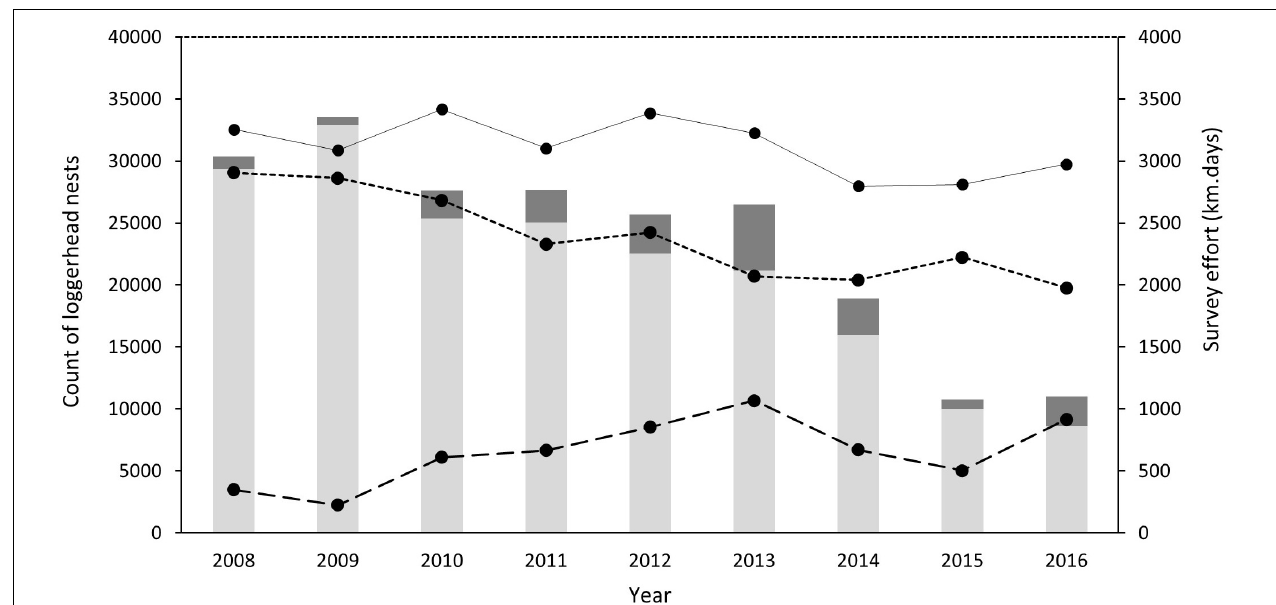
FIGURE 2 | Annual loggerhead nest counts and survey effort of index and non-index beaches on Masirah (2008–2016). Light gray bars represent total annual counts of nests on index beaches and dark gray total annual counts of nests on non-index beaches. Points associated with the continuous line represents the annual survey effort for all beaches, the short-dashed line represents survey effort associated with index beaches and the long dashed line the survey effort of non-index beaches (km